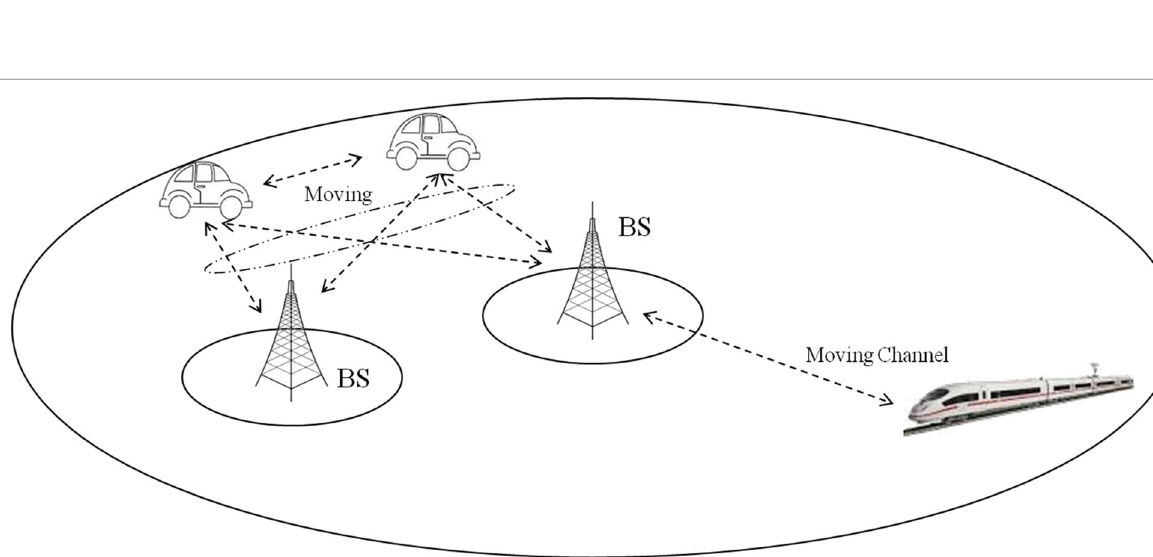
Fig. 20 High-mobility scenario for